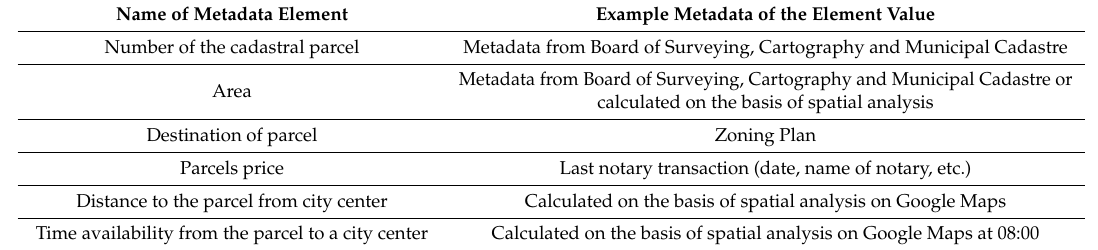
Table 1. The metadata hierarchy in the prototype. The first column represents the name of sample metadata element, describing the cadastral parcel. The second column represents the sample source of the value of this metadata element, which is metadata for metadata